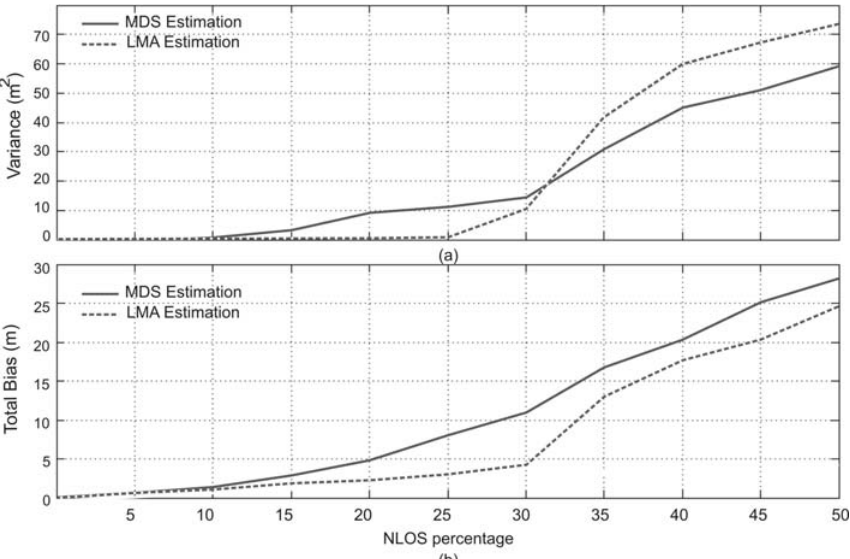
Figure 10. Errors in the position estimation considering NLOS effect between nodes N N , N , N and N (according to the distribution shown in Figure 5) (a) Total variance in 2 6 13 3 the coordinate estimation. (b) Total bias in the coordinate